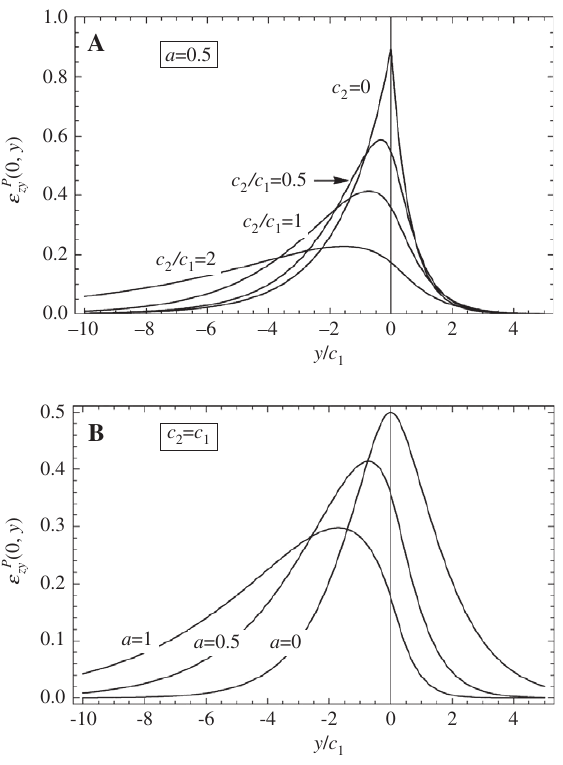
= 0, 0.5, 1, and 2, and (B) when c / c 2 1